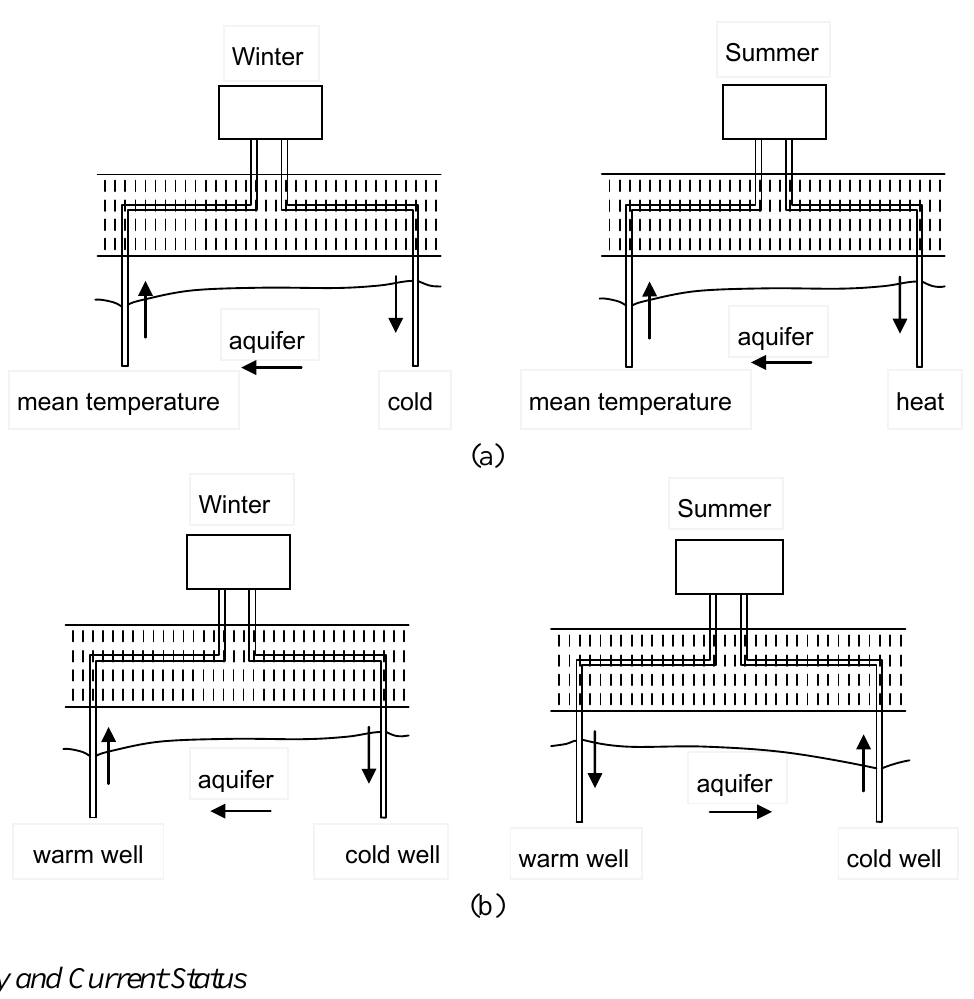
Figure 1. Basic operational regimes for aquifer thermal energy storage (a) continuous regime. (b) cyclic regime. (after Nielsen